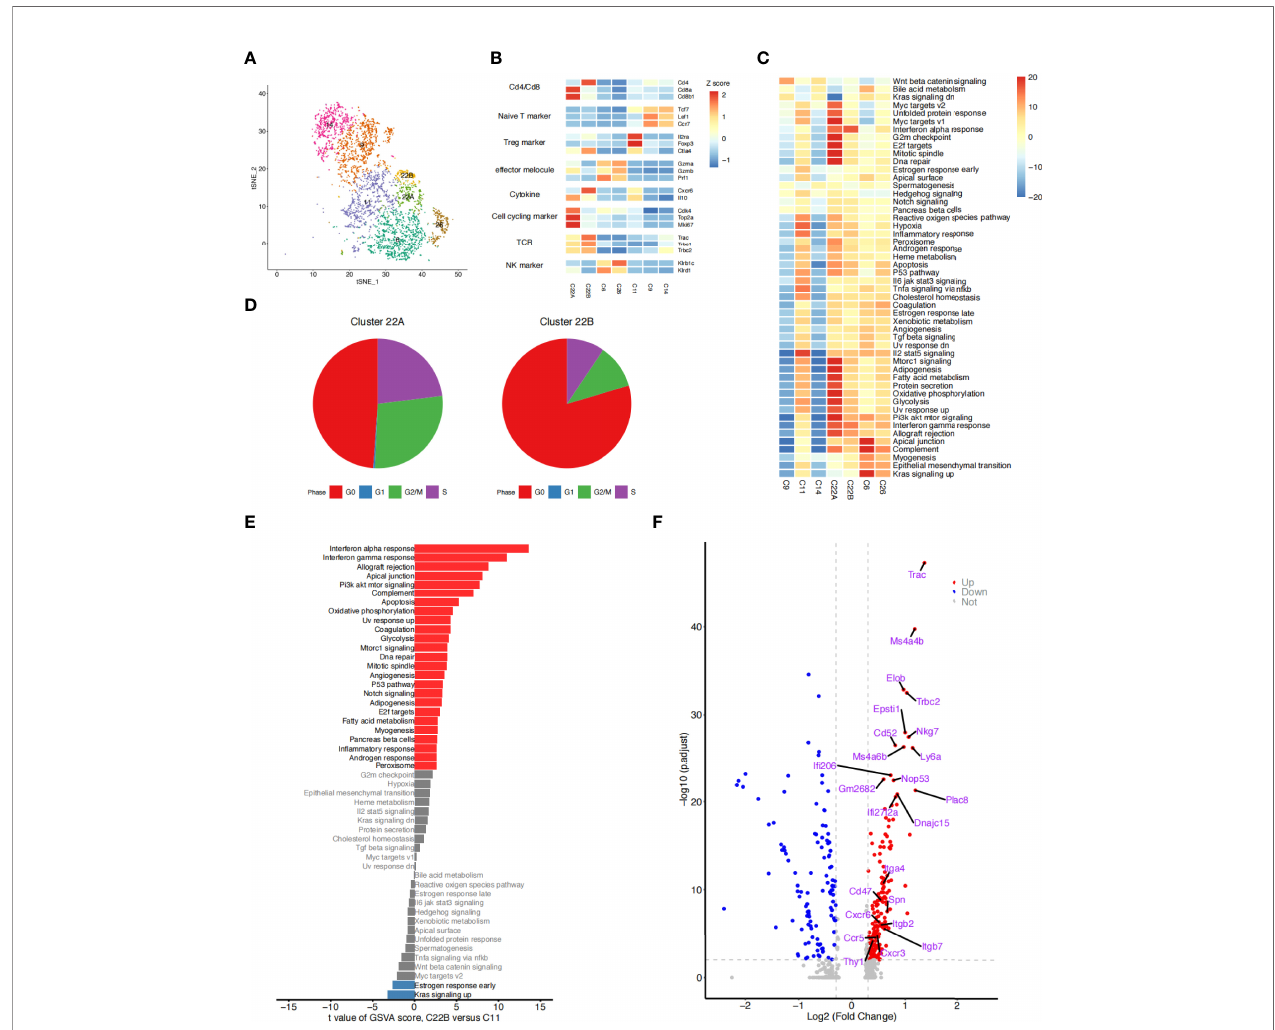
FIGURE 4 | Detailed characterization of T/NK cells. (A) t-SNE plot of 3,617 T and NK cells, color-coded by the re-clustered cell subtypes. (B) Heatmap of the average expression of selected function-related marker genes in seven T and NK cell clusters. (C) Heatmap of the differences in pathway activities between seven clusters of T and NK cells. Data shown are t values scored per cell from a linear model between every two groups by gene set variation analysis (GSVA). (D) Pie plots showing the fraction of the cells in clusters C22A and C22B during the cell cycle. (E) Bar plots showing differences in the hallmark pathway activities of T cells of two groups: clusters C22B and C11. Data shown are t values scored per cell from a linear model between the two groups by GSVA. The red columns represent the signi fi cantly upregulated functional pathways in C22B cells compared with C11 cells (P ≤ 0.05, t > 0); the blue columns represent the downregulated functional pathways in C22B cells compared with C11 cells (P ≥ 0.05, t < 0); and the gray columns represent the functional pathways that were not signi fi cantly expressed in C22B cells compared with C11 cells (P ≥ 0.05). (F) Volcano diagram displaying the differentially expressed genes (T cells of C22B versus C11). Each red dot was considered a signi fi cantly upregulated gene with an adjusted P value < 0.01 and fold-change ≥ 0.3; each blue dot was considered a signi fi cantly downregulated gene with an adjusted P value < 0.01 and fold-change ≤ -0.3; and the grey dots were considered insigni fi cant genes ( P value > 0.01 and -0.3 < logFC < 0.3). The fi rst 15 genes that were signi fi cantly upregulated and the 9 receptor genes that were previously screened are